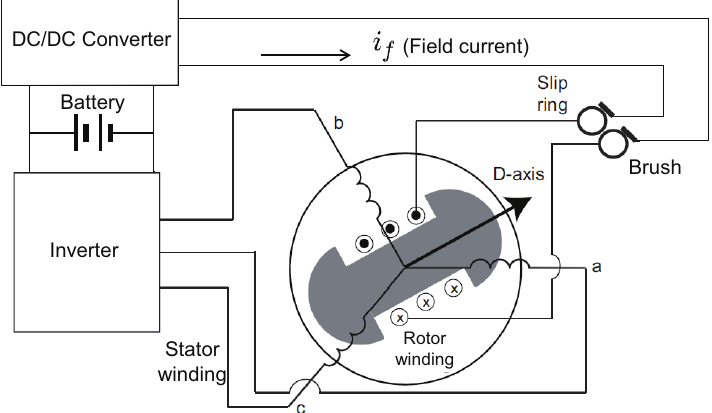
Figure 1. Schematic Diagram of WSM for EV